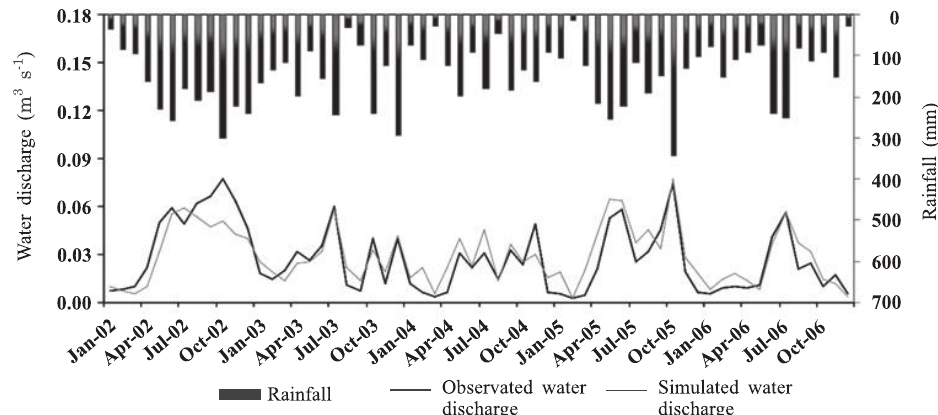
figure 1. total monthly flow discharge (observed and simulated) vs rainfall from 2002 to